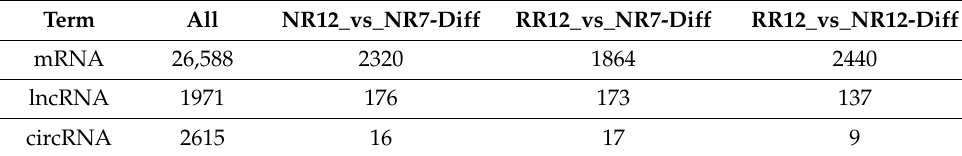
Table 2. Statistical table of sequence prediction